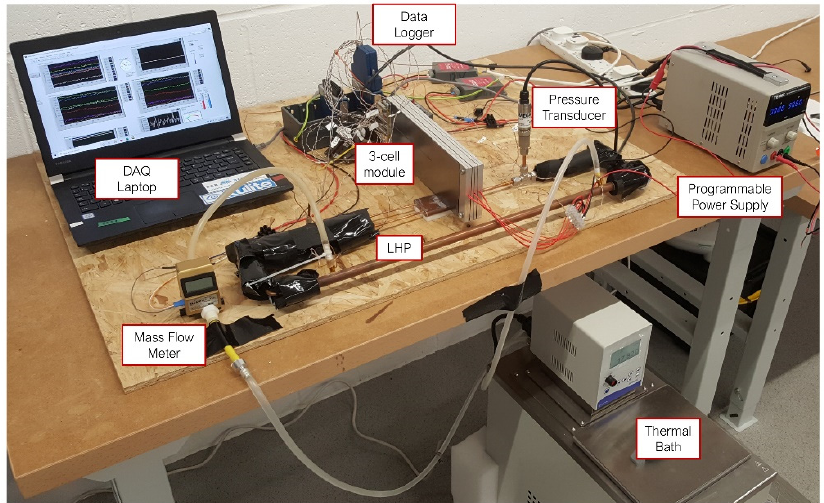
Figure 5. Experimental Set-up used for this